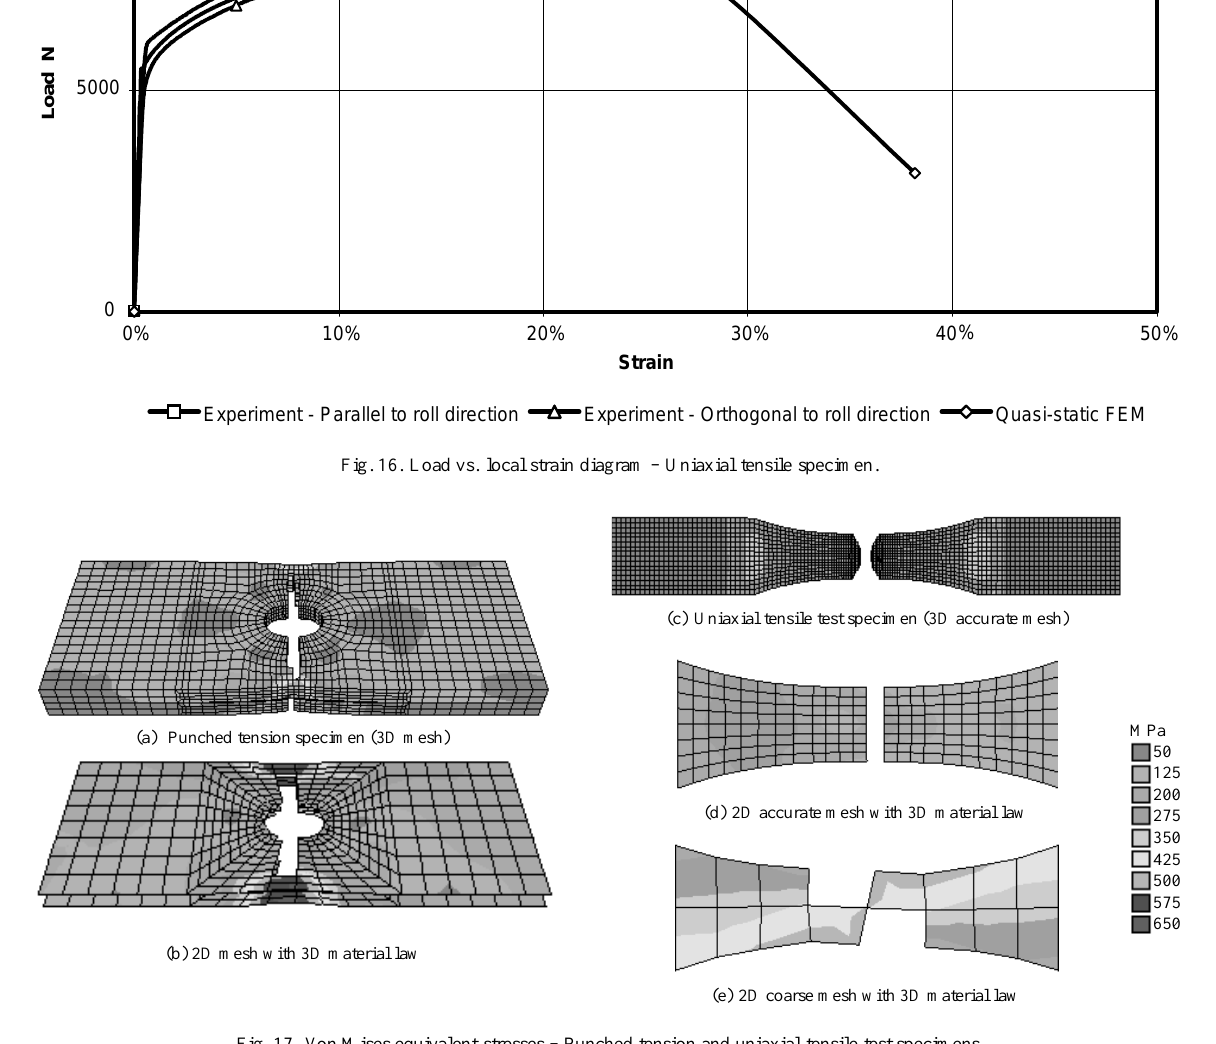
Fig. 17. Von Mises equivalent stresses – Punched tension and uniaxial tensile test